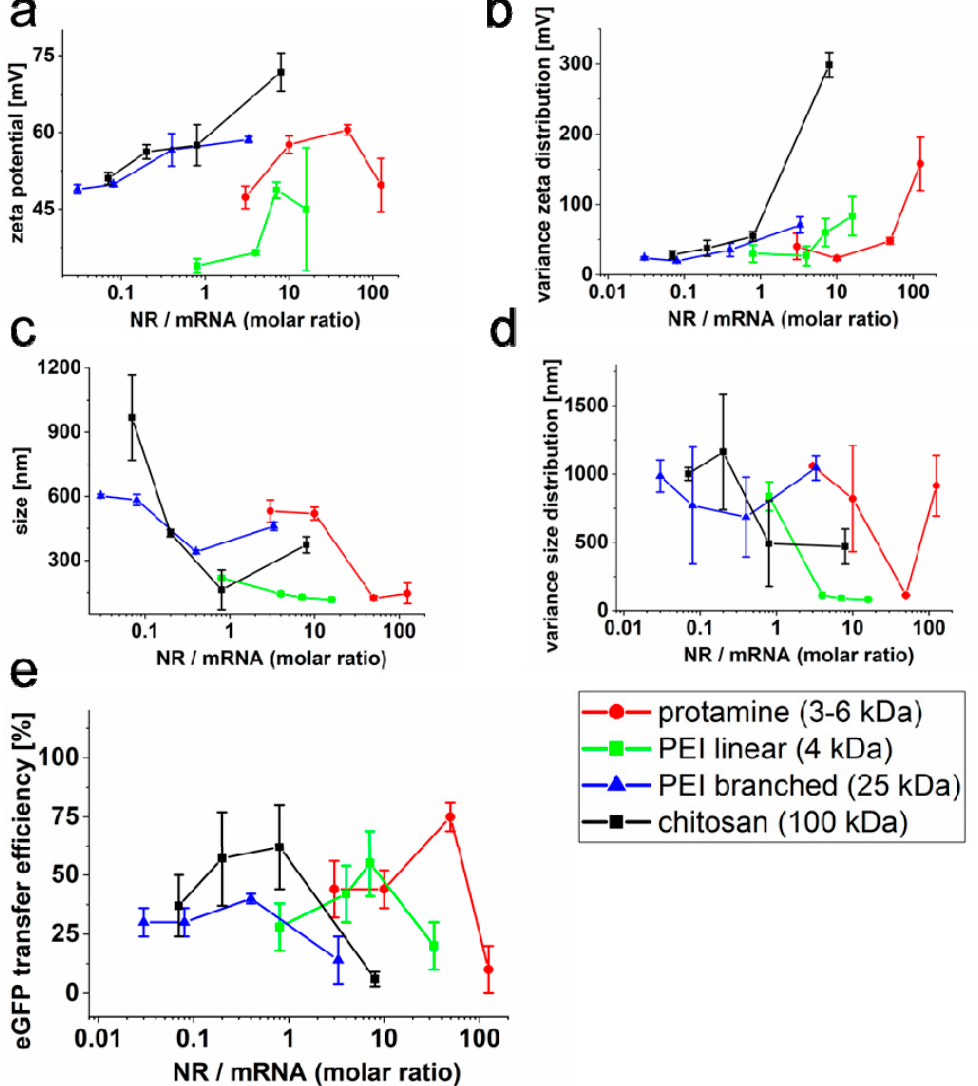
Figure 2. Influence of neutralization reagents and ratios on liposomal complex charge and size. Protamine, linear, and branched PEI and chitosan were tested as NR to efficiently incorporate NA into FLs and enable the efficient transfer of mRNA. Zeta potentials ( a ), variance of zeta potentials ( b ), complex size ( c ), and variance of complex sizes ( d ) are the most prominent characteristics that influence transfer efficiencies of FLs ( e ). Highest transfer efficiencies were achieved with maximal high zeta potentials at the lowest zeta potential variance in combination with the smallest complex sizes and size variances for all four NRs. NR = neutralization reagent; NA = nucleic acid. Comparable results were found for all neutralization reagents tested. After incubation with eGFP–mRNA at NR/mRNA molar ratios from 0.03 to 100 and subsequent incubation with FLs, transfer efficiencies exhibited distinct optimum ratios again. Furthermore, the data argued for a